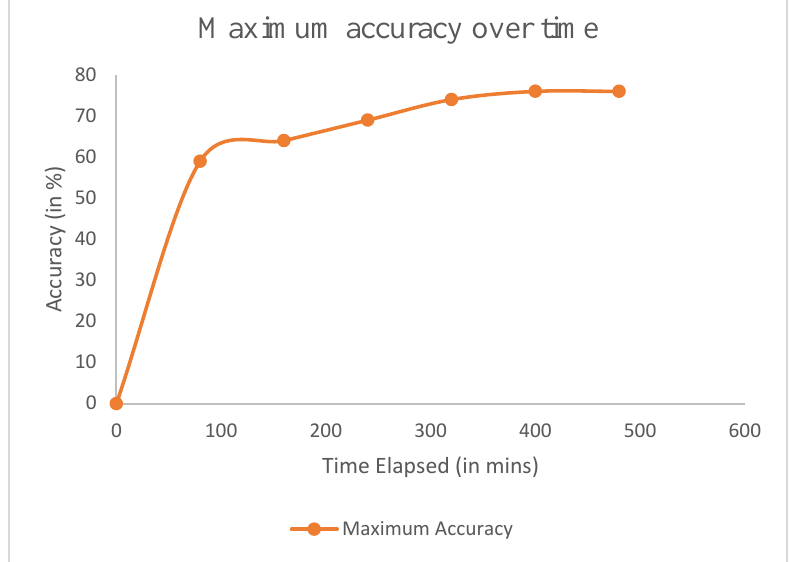
Figure 4. Accuracies of the evolved PFANET variants as the time elapsed.